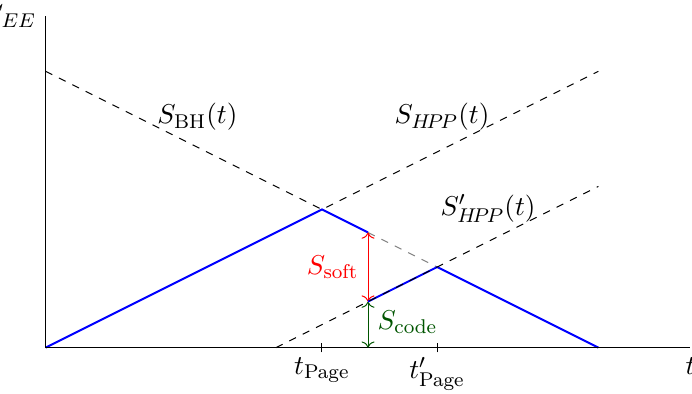
Figure 2. Page curve [38, 39] describing the evolution of entanglement entropy of the black hole with an infalling observer. The Bekenstein bound, S implies there must be a transition EE ≤ S BH preventing the entanglement entropy from continuing to grow at late times, as would be predicted by Hawking pair production, S ( t ) . The red segment indicates change in entropy when an HPP infalling observer measures soft hair while crossing the horizon. After the measurement, the black hole entropy again follows the upward slope S 0 ( t ) prescribed by the Hawking process. HPP section 5, this allows for the reconstruction of the Hawking partners inside the black hole via the Petz map [40,